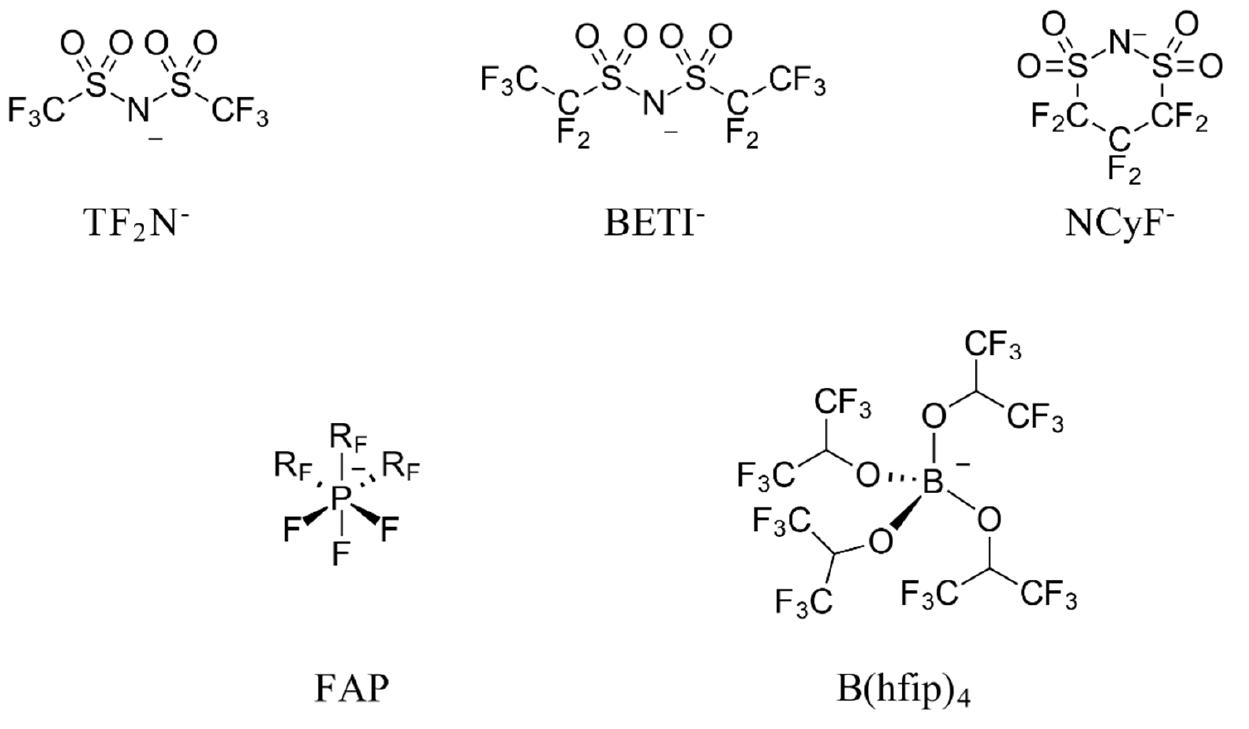
Figure 1. Common perfluorinated anions used in the development of ionic liquids and the abbreviations used herein.